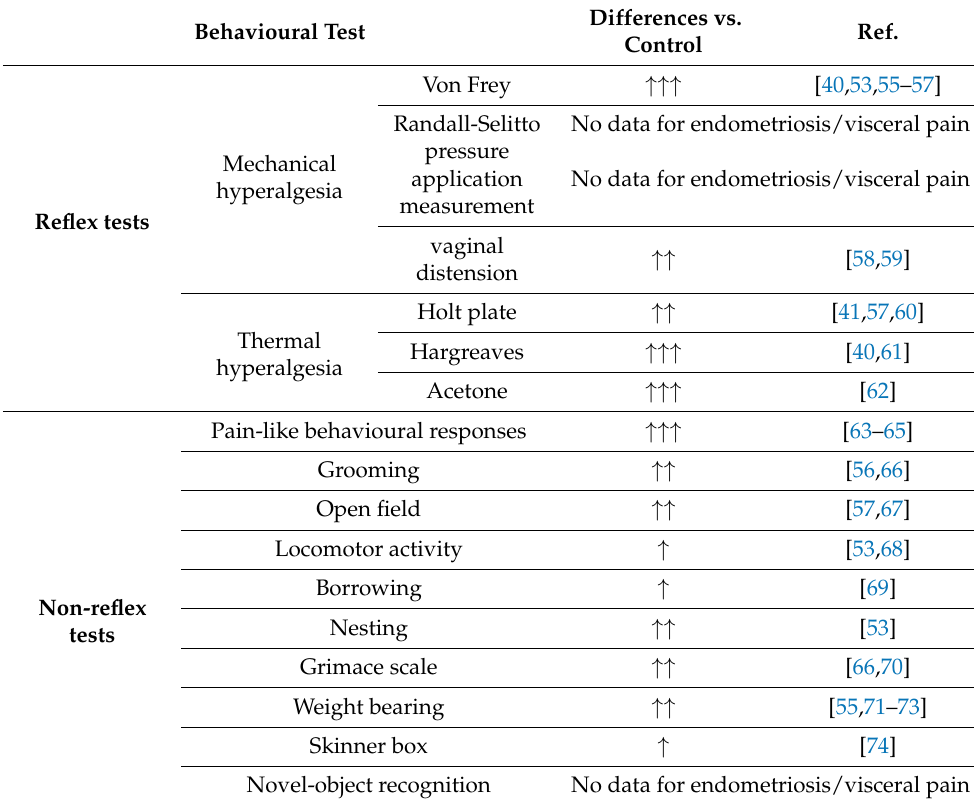
Table 2. Summary of effects of endometriosis or visceral pain on different tests. The number of arrows represents the grade of differences between the group in which pain was induced versus its control group (one arrow means little differences, two arrows medium, and three high differences). Differences vs. Behavioural Test Control